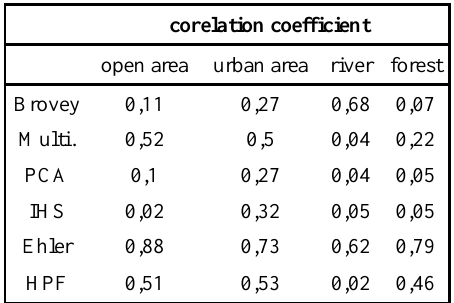
Table 1. Correlation coefficients of the pan-sharpened images Values of correlation coefficient determined for pan-sharpened images derived from one satellite, for example World View-2 are order of 0.8-0.9 (Samadzadegan and DadrasJavan, 2011). Thus values obtained in this studies should be regarded as low. The reason is the fact that spatial resolution of the multispectral image is the correlation related to images for which image resolution multispectral is multiple lower than the panchromatic image. What is more, the low correlation coefficient could be also affected by large (5-year) interval between